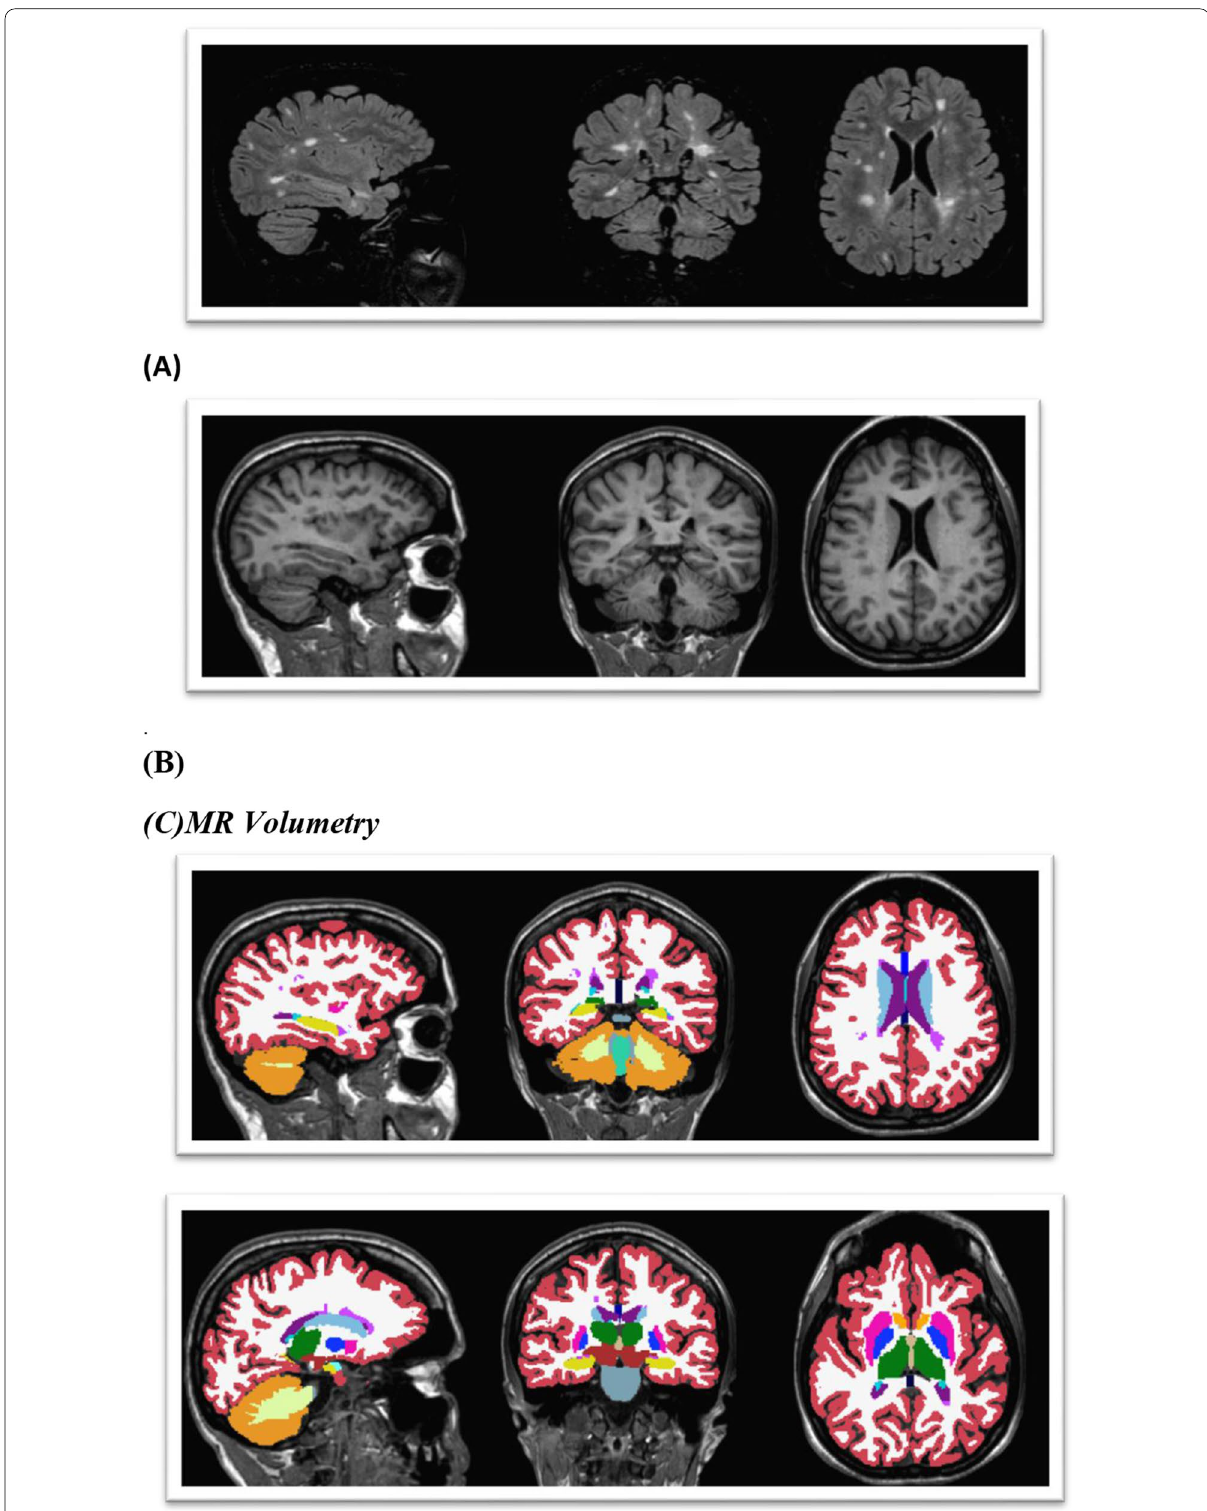
Fig. 10 22 year old female diagnosed with MS 6 years ago with EDSS (4) with features of cognitive impairment. ( A ) 3D FLAIR images showing multiple foci and patchy areas of high signal intensity implicating the peri ventricular and juxta cortical white matter ( B ) 3D T1 images showing multiple foci and patchy areas of slightly low signal intensity implicating the peri ventricular and juxta cortical white matter. ( C ) MR